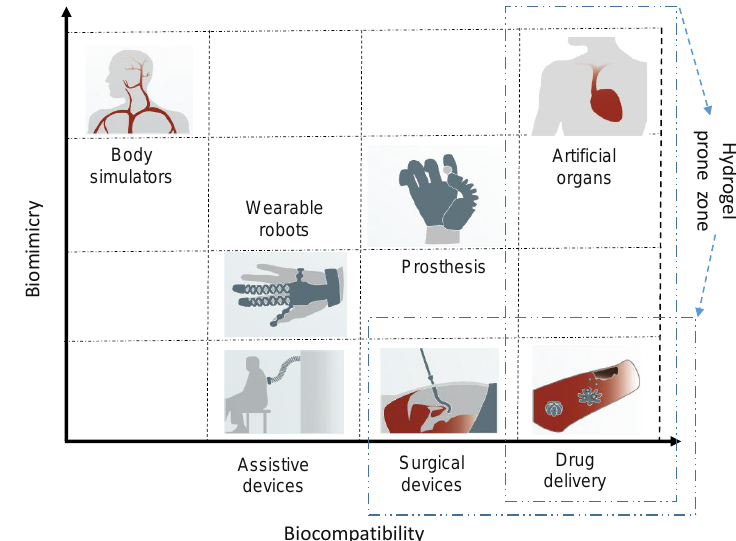
Figure 3. Biomedical soft robotic application areas from a materials’ perspective. The denoted region is best suited for hydrogel soft robotic applications in biology and medicine. Concept adapted with permission from [95]. Copyright 2018, Springer Nature